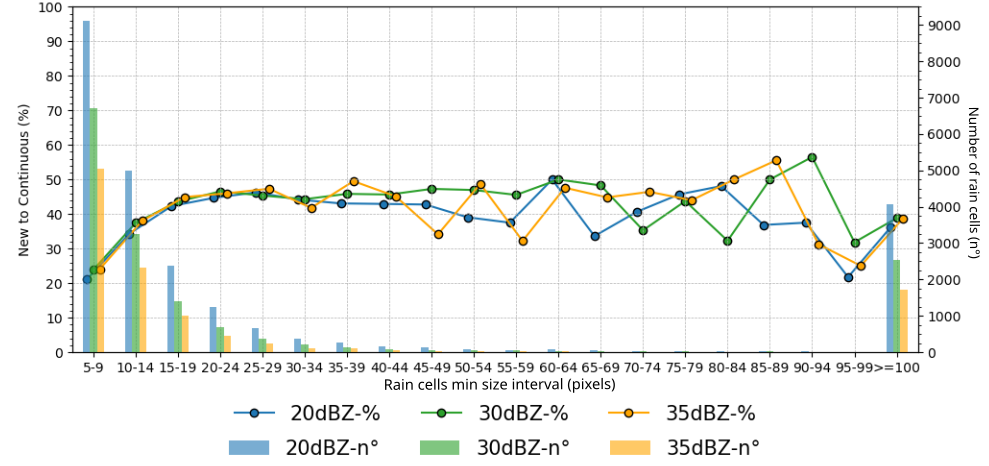
Figure 9. Distribution for the number of rain cells (clusters) in transition from New to Continuous for thresholds of 20, 30, and 35 dBZ. The lines represent the percentage of continuity and the bars the total of rain cells observed for each interval and